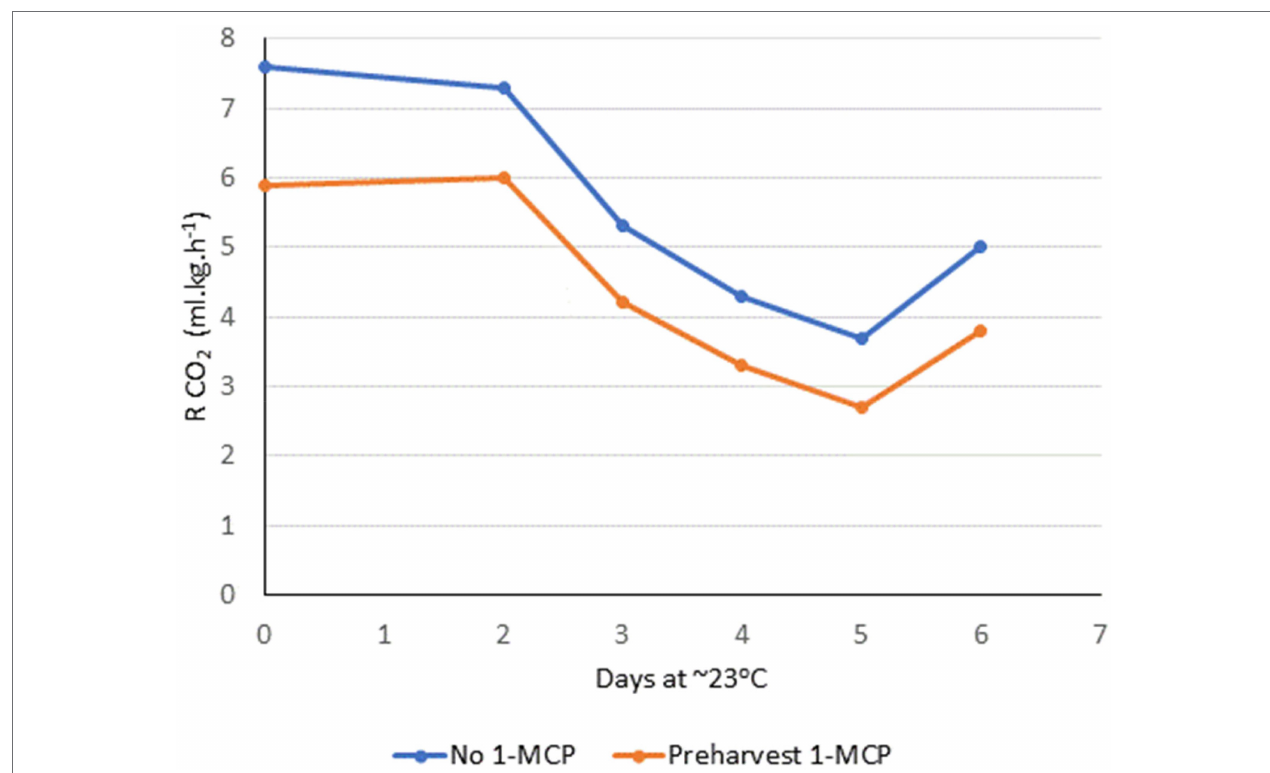
FIGURE 1 | Respiration rate of ‘Gala’ apples without or with preharvest 1-MCP held for 6 days at room temperature (~23 ° C) immediately after harvest, as measured by CO 2 production using SafePod ™ technology.